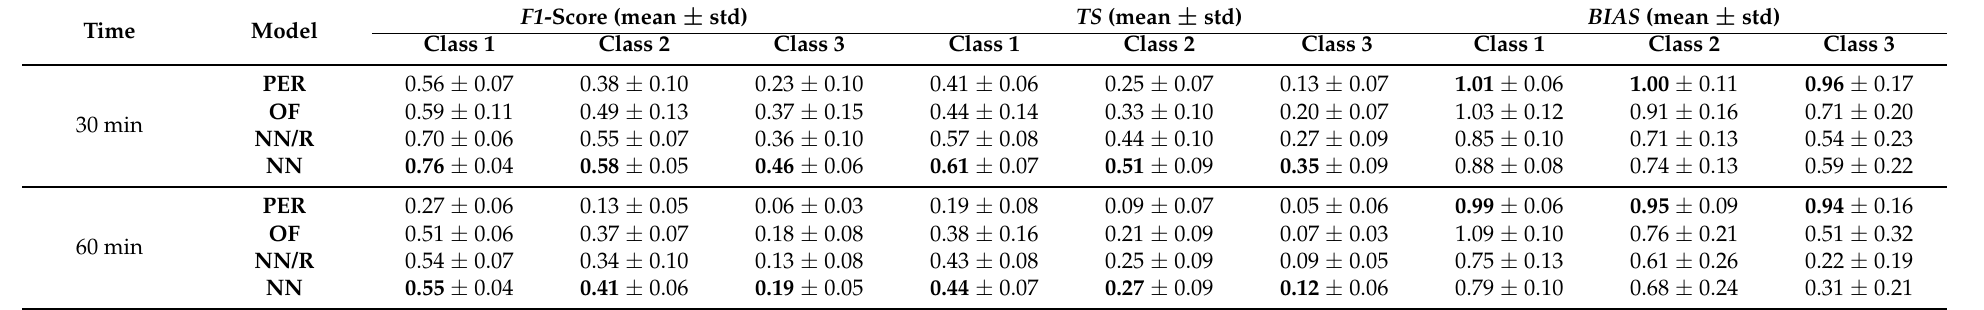
Table 3. Comparison of models’ results on F1 , TS , and BIAS scores (mean ± standard deviation) for the three classes calculated on the test set (bold numbers denote the best score).